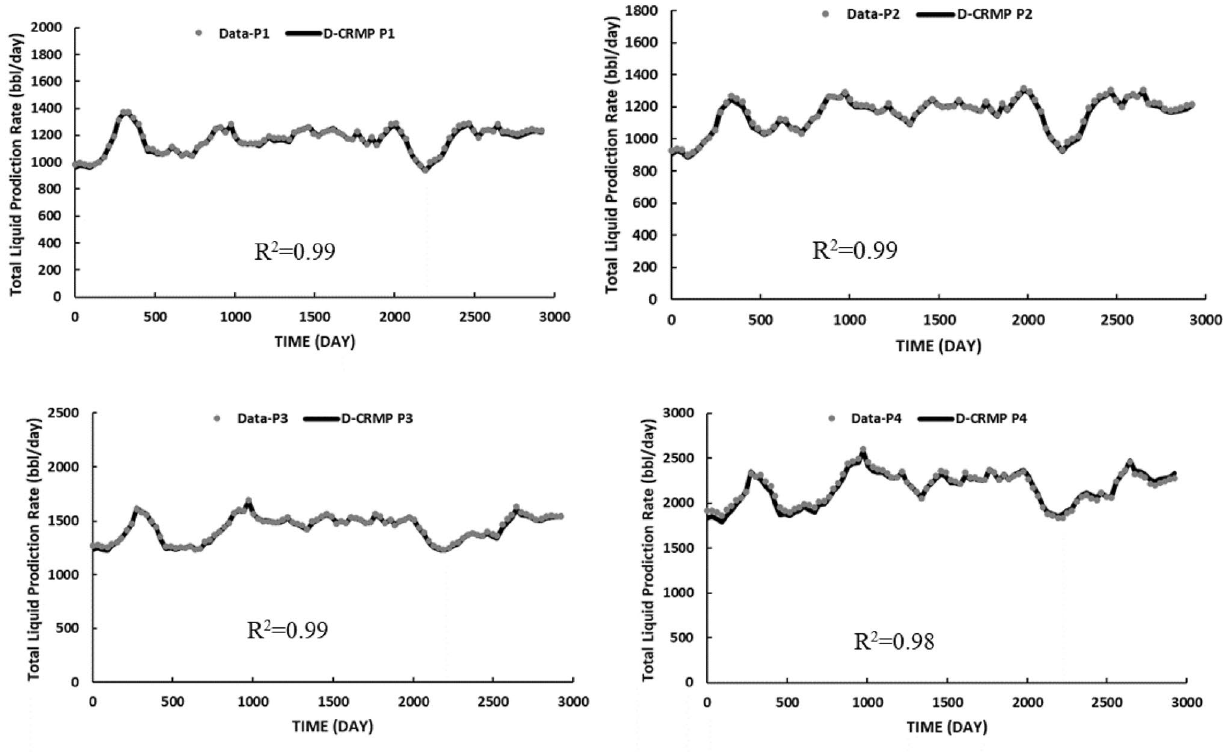
Fig. 5 Liquid production rates match by D-CRMP in case